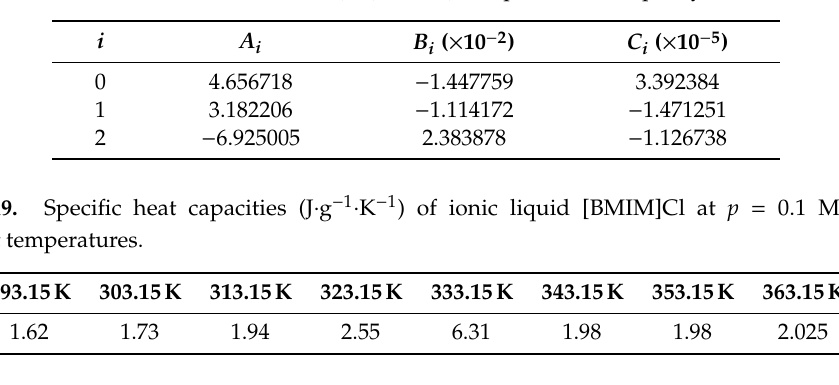
Table A8. Values of A i , B i , and C i for specific heat capacity.